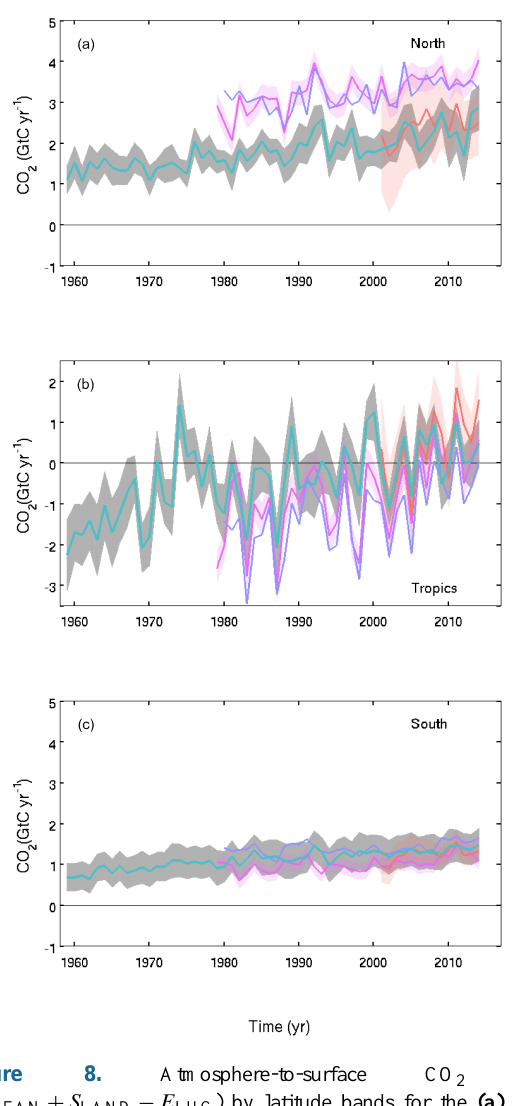
Figure 8. Atmosphere-to-surface CO 2 flux ( S OCEAN + S LAND − E LUC ) by latitude bands for the (a) north (north of 30 ◦ N), (b) tropics (30 ◦ S–30 ◦ N), and (c) south (south of 30 ◦ S). Estimates from the combination of the multi-model means for the land and oceans are shown (turquoise) with ± 1 σ of the model ensemble (in grey). Results from the three atmo- spheric inversions are shown in purple (Chevallier et al., 2005; MACC, v14.2), violet (Rödenbeck et al., 2003; Jena CarboScope, s81_v3.7), and salmon (Peters et al., 2010; Carbon Tracker, vCTE2015); see Table